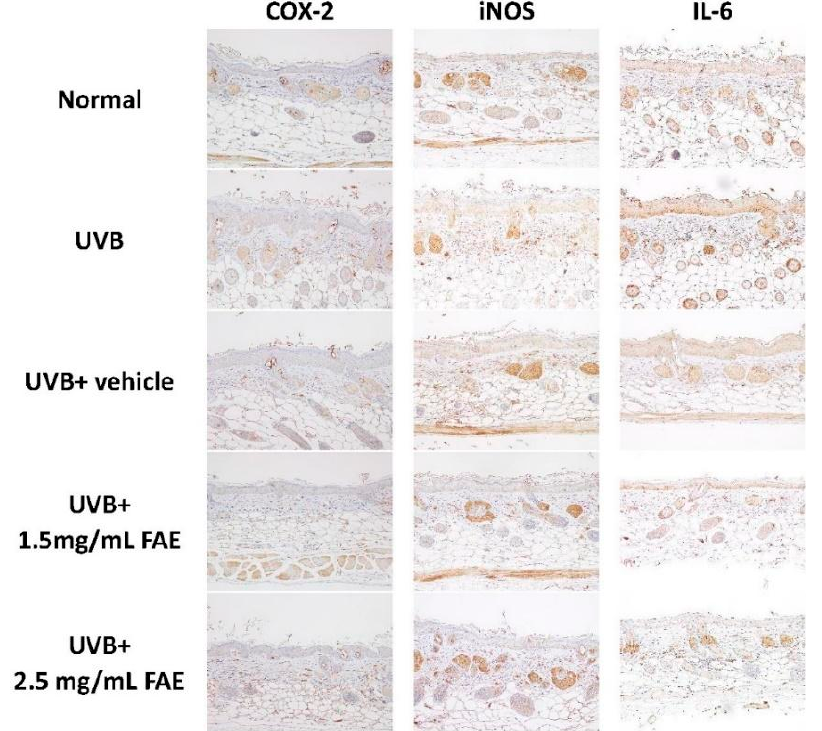
Figure 9. The inhibitory effects of Ficus awkeotsang Makino extract (FAE) in BALB/c nude-mice dorsal skin after UVB irradiation. The protein expression after different treatments were determined immuno-histologically by staining the tissue sections blotted with the COX-2, iNOS, and IL-6 antibody.